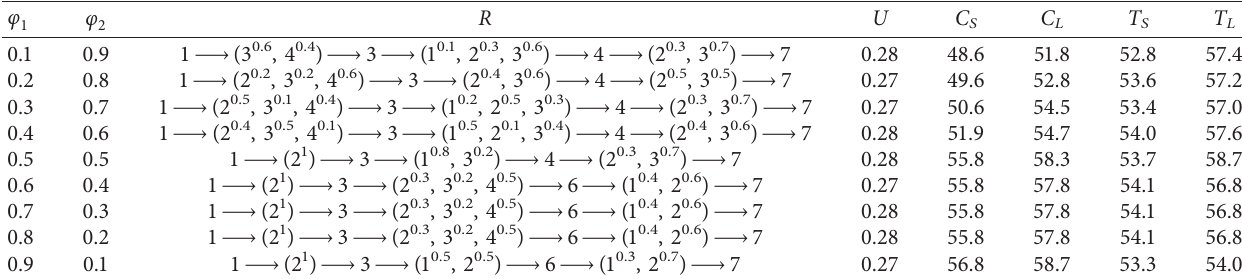
Table 7: The impact of φ